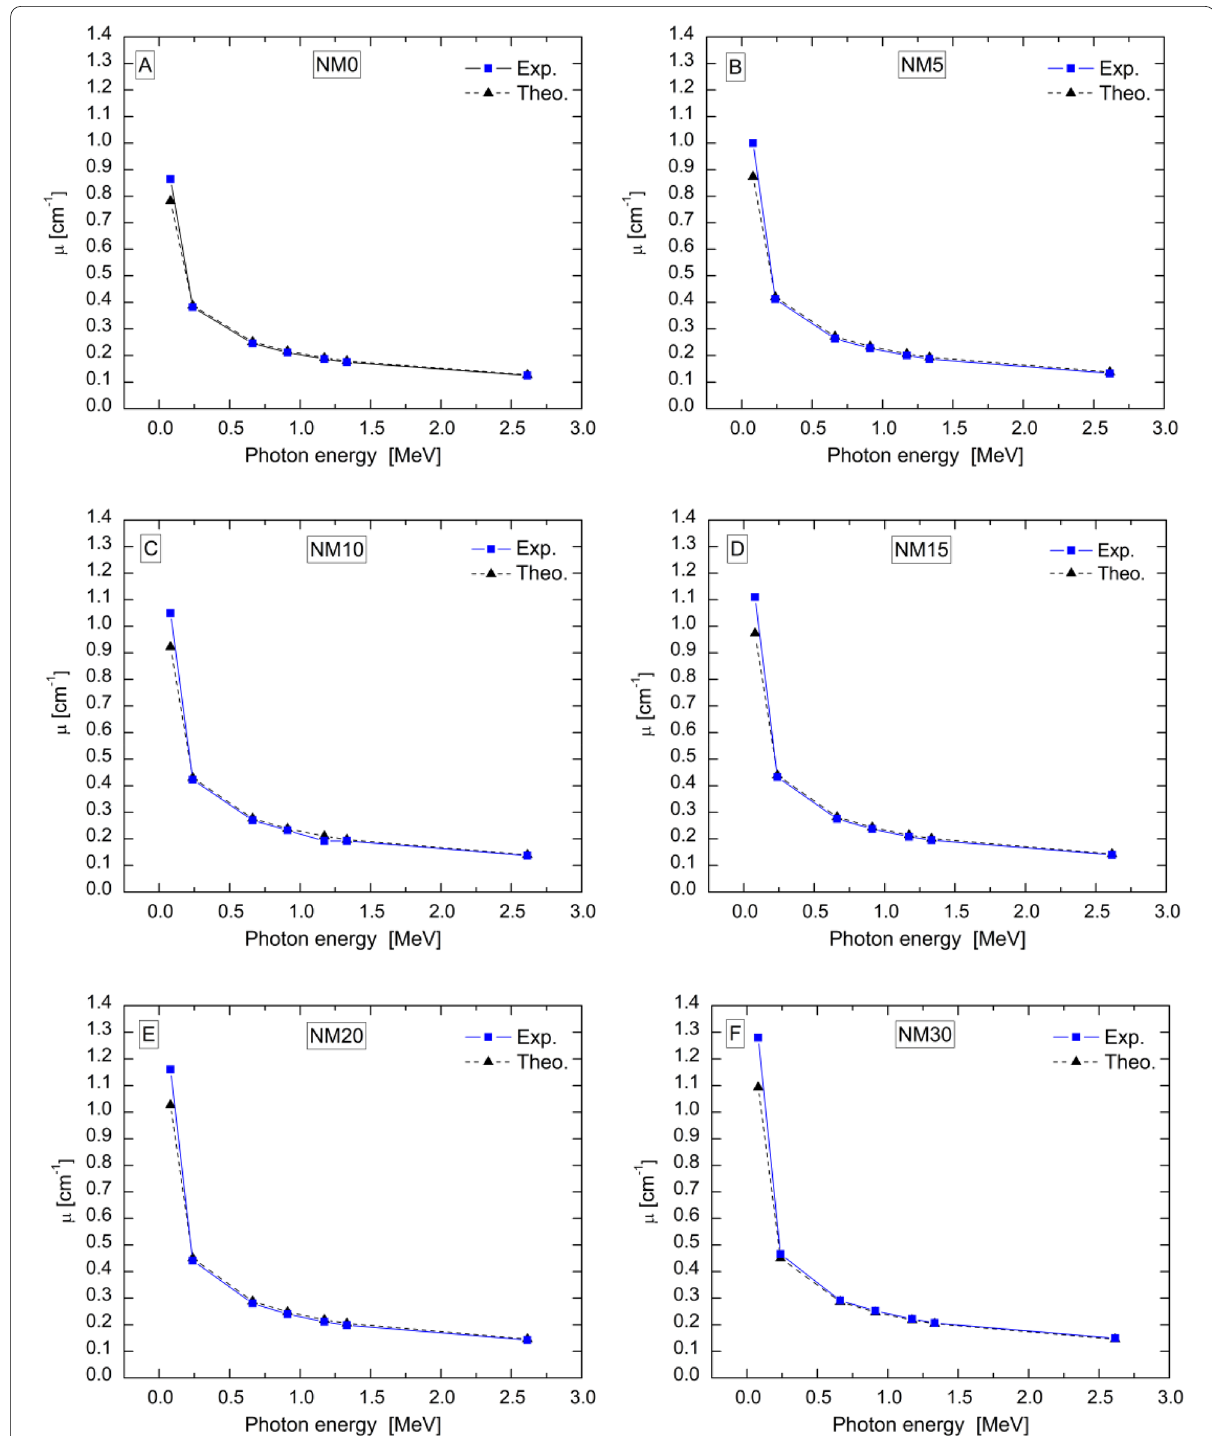
Fig. 10 Experimental and theoretical linear attenuation coefficients of a NM0, b NM5, c NM10, e NM15, e NM20 f , and NM30 g as a function of photon